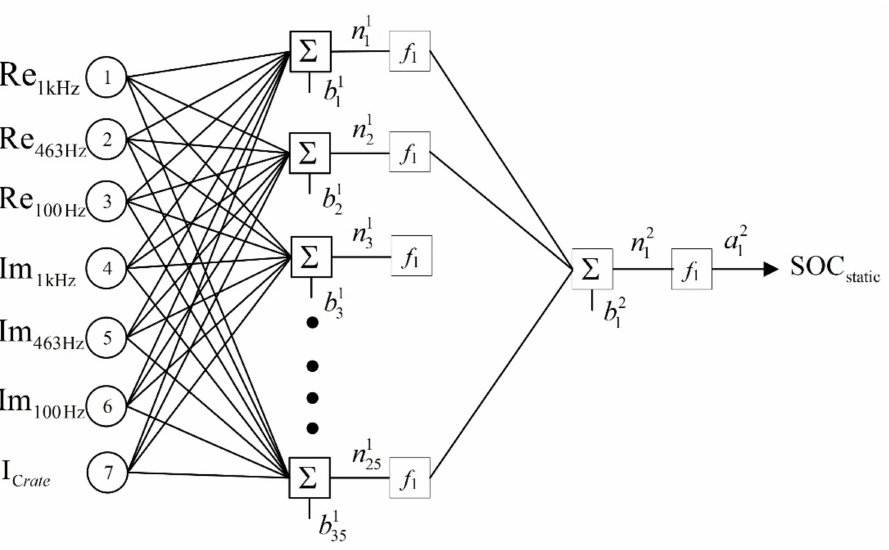
Figure 6. Configuration of the utilized artificial neural